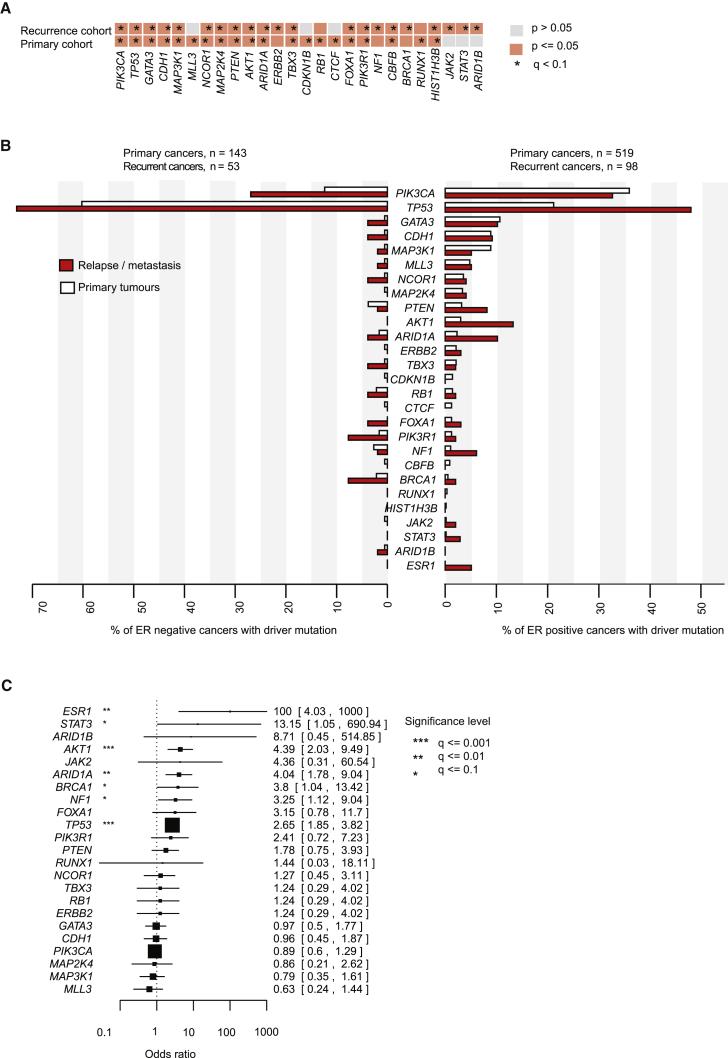
Comparison of the Driver Landscapes of 163 Recurrent and 705 Primary Breast Cancers(A) Cancer genes identified as significantly mutated with a false discovery rate (q) < 0.1, applied to the TCGA 705 primary breast cancer exomes or the 163 recurrent breast cancers independently.(B) Barplots compare the prevalence of each significantly mutated cancer gene and ESR1 in the primary and recurrent breast cancer cohorts (662 and 151 cases, respectively, where the estrogen receptor status of the primary tumor was documented).(C) Forest plot comparing the frequency with which cancer genes are mutated in the relapse cancer cohort (163 cases) compared with the primary tumor cohort (705 cases). Enrichment for each gene was determined using two-sided Fisher's exact tests and Benjamini and Hochberg correction. Box size is scaled to the number of cases and whiskers, and numbers inside brackets represent the 95% confidence interval for the odds ratio (the upper limit is clipped at 1,000).